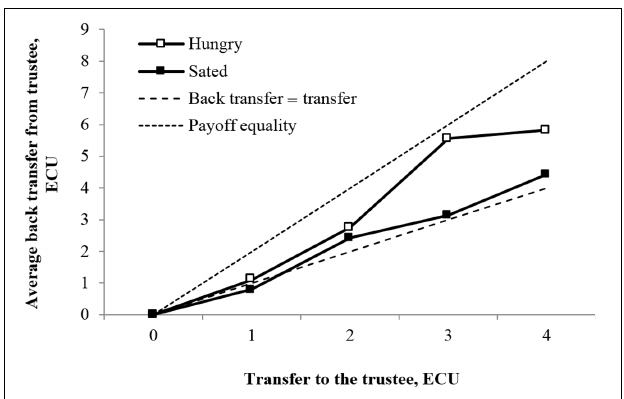
FIGURE 2 | Distribution of back transfers from the trustee in the trust game reported separately for treatment (sated) and control (hungry) conditions. N = 130 ( N sated = 66, N hungry = 64).